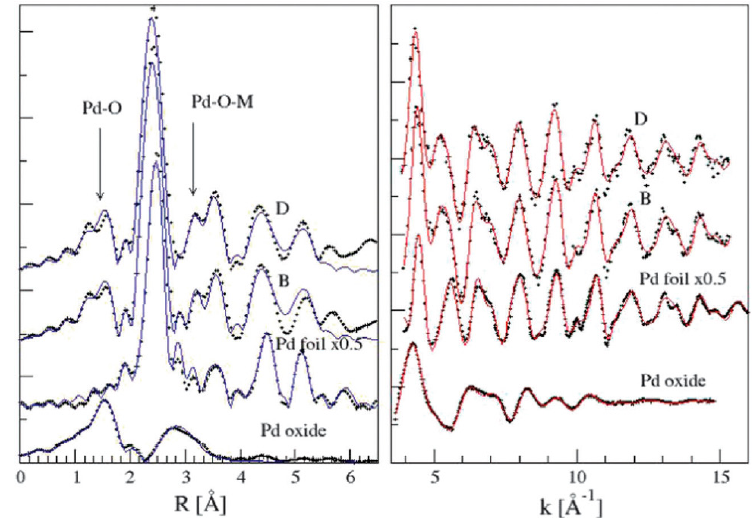
Figure 5. The fitting extended X-ray absorption fine structure (EXAFS) data of the samples LSCF0.2-Pd (B), LSCF0.8-Pd (D) and Pd oxide. (Reprinted with permission from